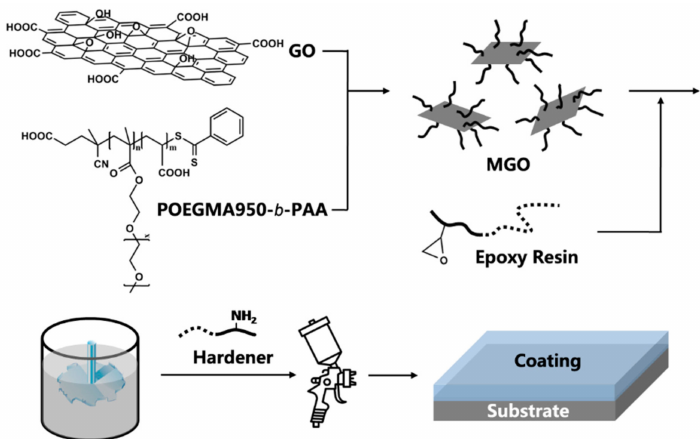
Figure 1. Schematic illustration of the preparation of the waterborne epoxy-graphene oxide coatings